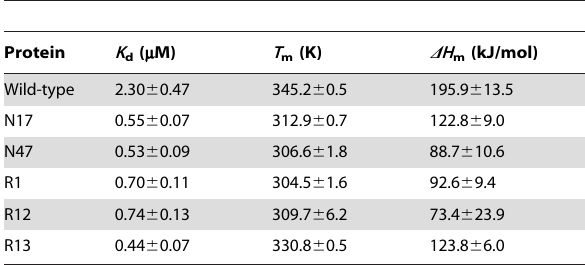
Table 1. Kinetic and thermodynamic parameters for the wild- type and SH3 variants.